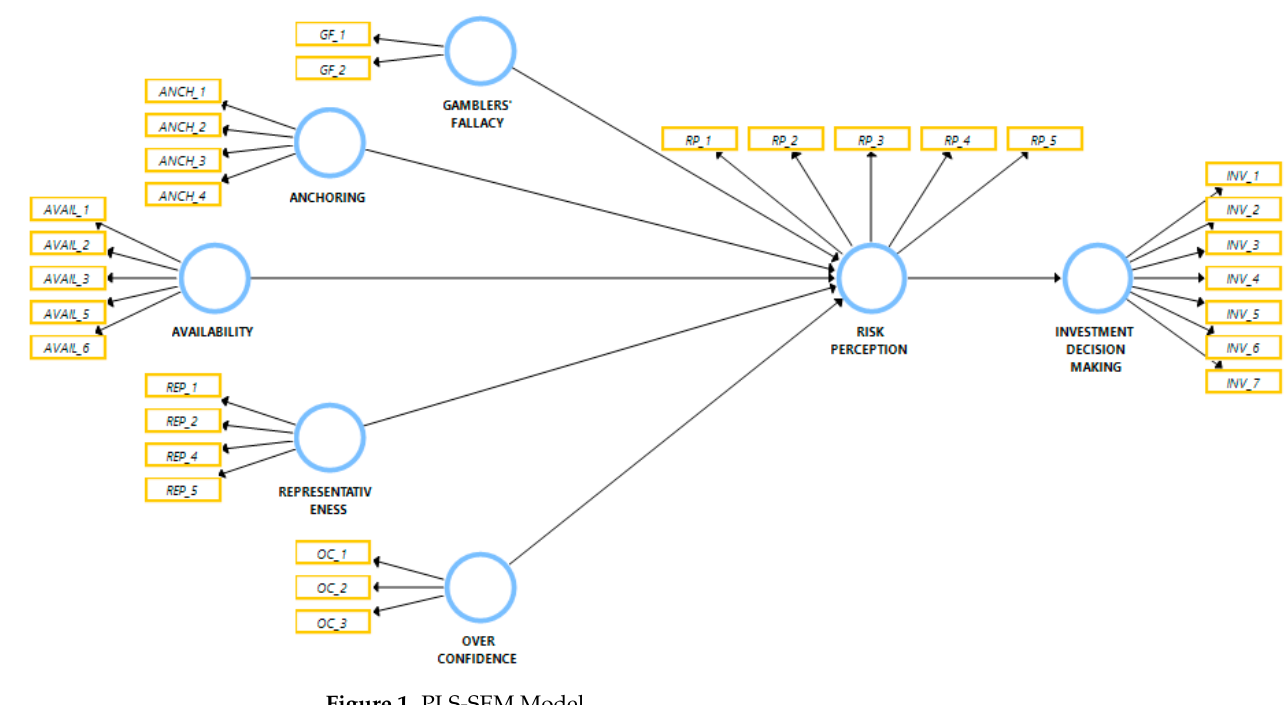
Figure 1. PLS-SEM Model.